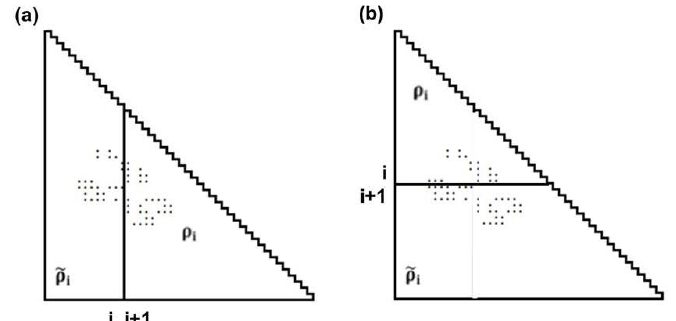
Figure 10. Schematic drawing of a map divided by a line parallel to the ordinate at the i -th residue ( a ), and divided by a line parallel to the abscissa at the i -th residue ( b ). The density of plots in the trapezoidal part and the triangular parts are denoted by ̃ and ,